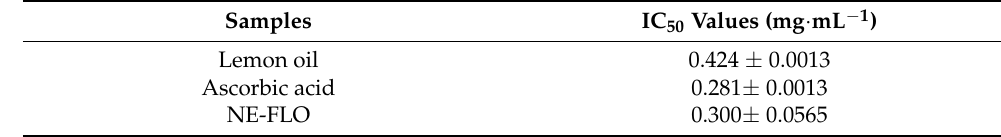
Table 3. The IC50 value of lemon oil, NE-FLO, and ascorbic acid used in the DPPH